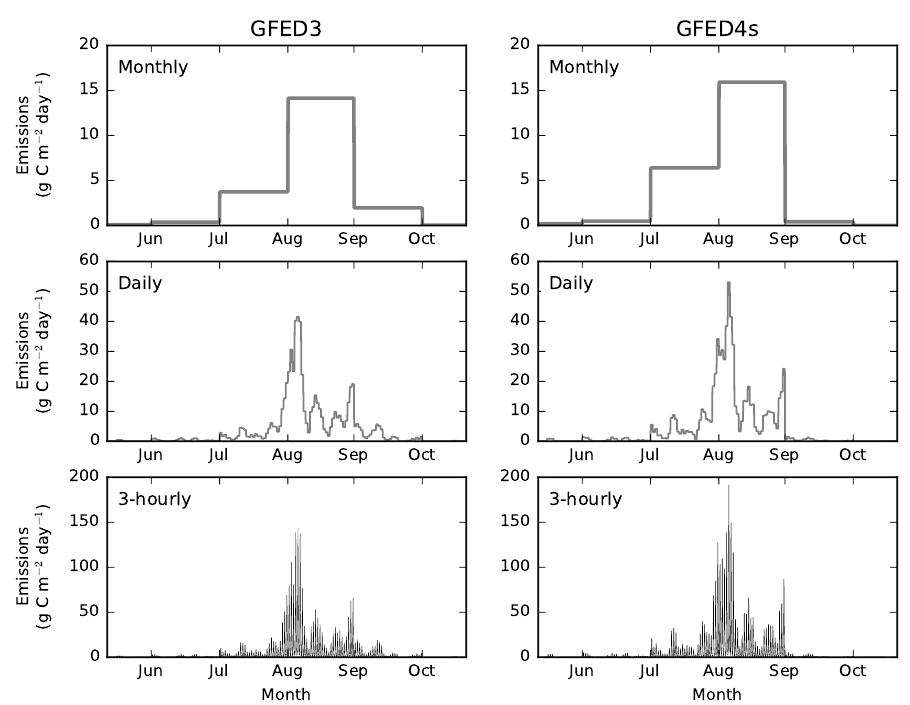
Figure 7. Comparison of monthly (top panels), and disaggregated daily (middle) and 3-hourly (bottom) emissions from GFED3 (left-hand side) and GFED4s (right-hand side) for an example grid cell in South America (11.75 ◦ S, 51.75 ◦ W).